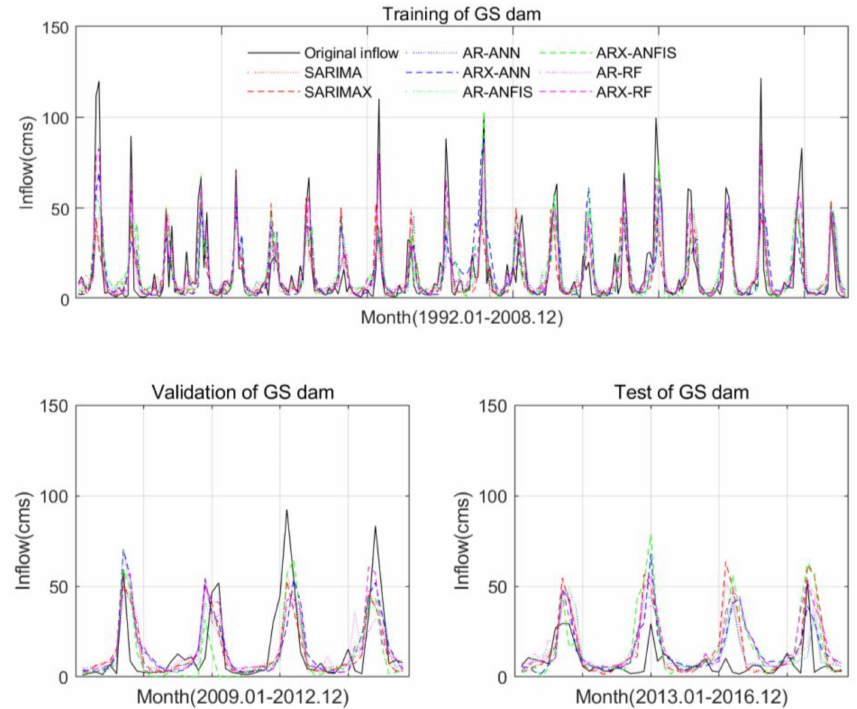
Figure 13. Forecasting results from the eight models in the GS dam during the training, validation, and test periods (a part of the forecasting results in the training period of the SARIMA and SARIMAX models were illustrated for the validation